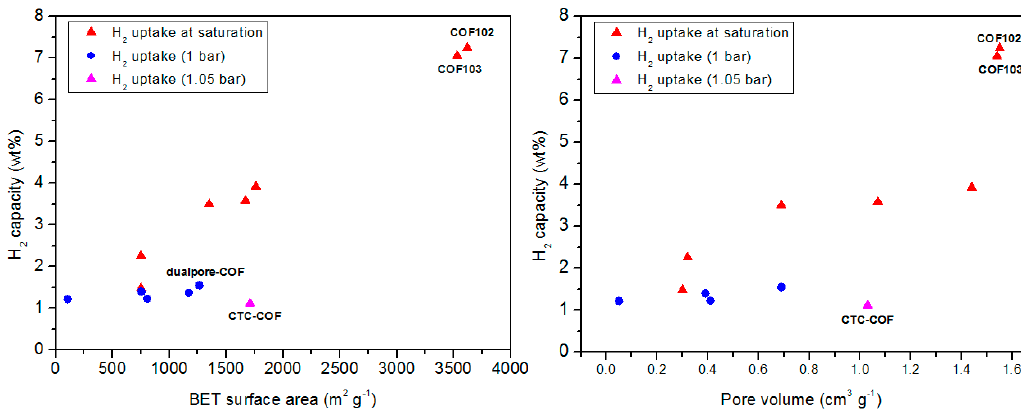
Figure 27. Plot of H 2 uptake against BET surface area ( left ) and pore volume ( right ) for the selected COFs at 77 K.